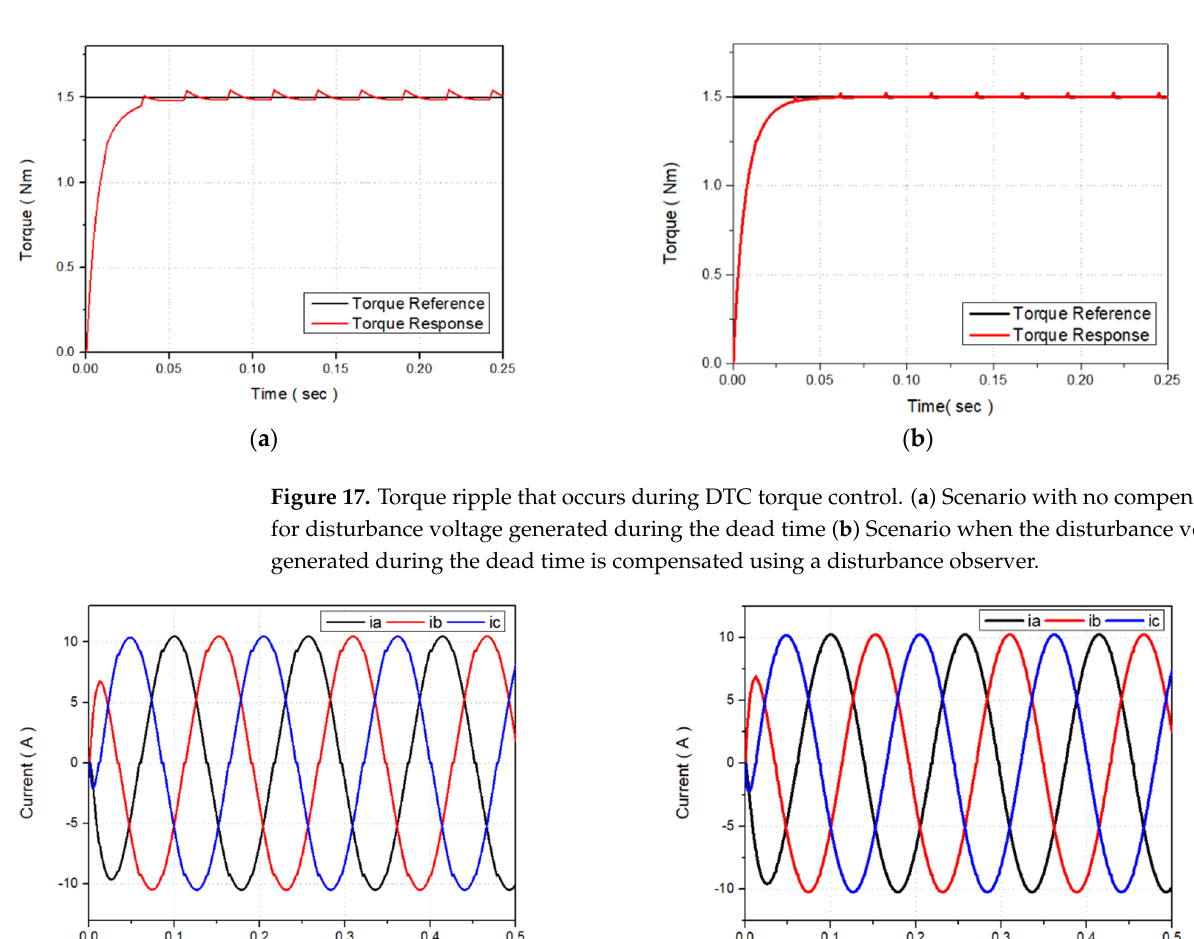
Figure 16. Trajectory of stator flux during DTC − SVM torque control. ( a ) Scenario with no compen- sation for disturbance voltage generated during dead time. ( b ) Scenario with disturbance voltage generated during dead time, which is compensated using a disturbance observer.